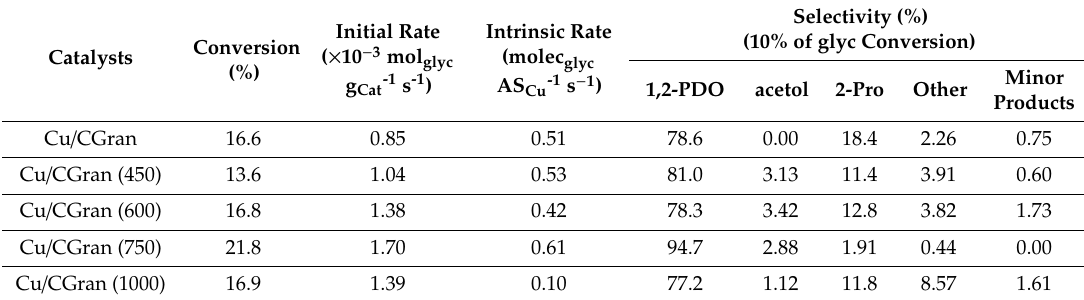
Figure 7. Catalytic activity of Cu / CGran and Cu / CGran(x) catalysts expressed as ( a ) Initial rate (r 0 ), ( b ) Intrinsic rate (r I ). Table 4. Catalytic activity and selectivity of Cu / CGran(x)